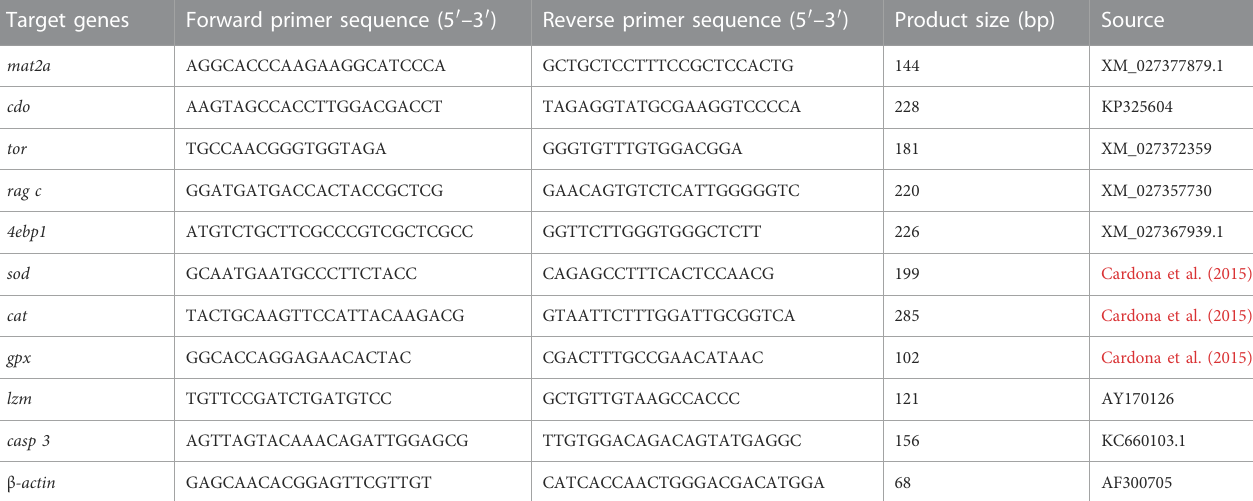
TABLE 3 Sequences of primers used in L. vannamei